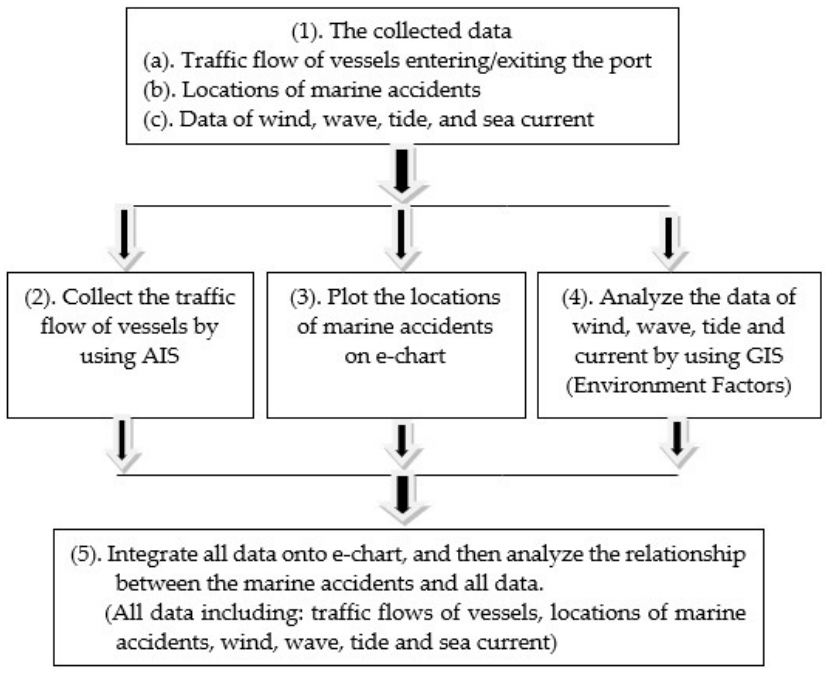
Figure 1. Diagram of research